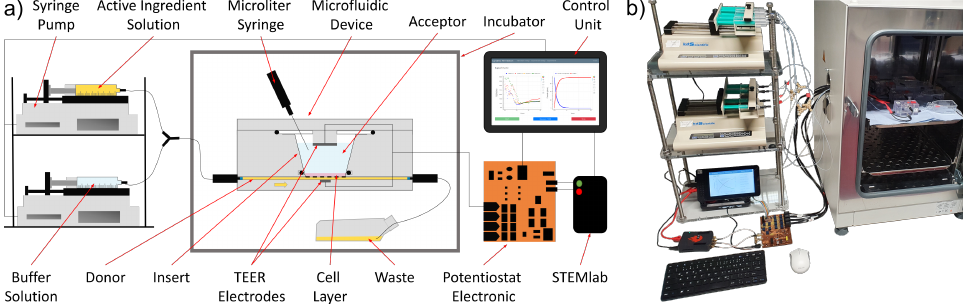
Figure 3. Automated test setup. ( a ) Schematic of the experimental setup and connections. ( b ) Photo of the experimental